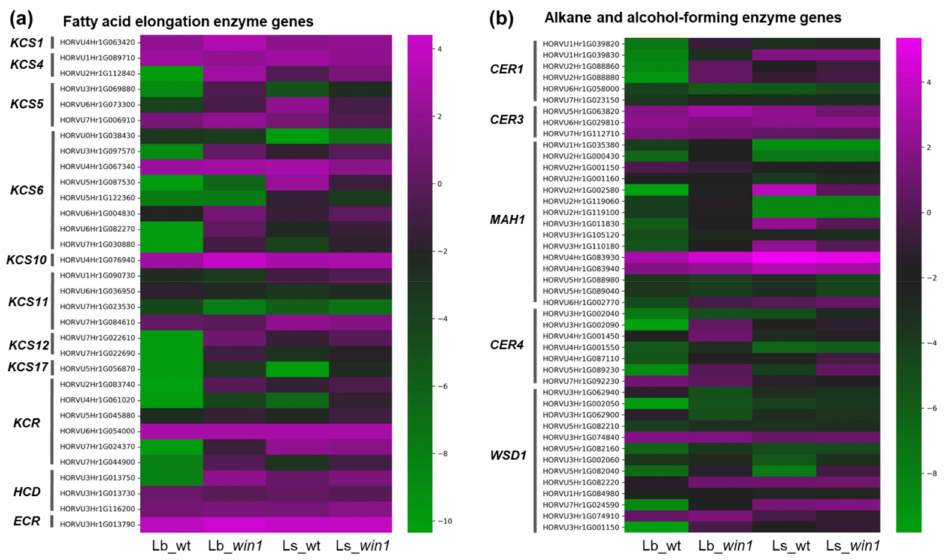
Figure 5. Expression heatmap of wax biosynthesis genes in wild-type and win1 KO leaf blades and leaf sheaths. ( a ) Expression of genes involved in fatty acid elongation. KCS—3-ketoac-CoA synthase, KCR—3-ketoacyl-CoA reductase, HCD—b-hydroxyacyl-CoA dehydratase, and ECR—enoyl-CoA reductase. ( b ) Expression of alkane and alcohol-forming enzyme genes. CER1, CER3—acyl-CoA de- carbonylases, MAH1—midchain alkane hydroxylase, CER4—fatty acyl-CoA reductase, and WSD1— wax ester synthase. The magenta color denotes highly expressed genes, and green indicates genes with lower expression. The magenta-green gradient represents the change in fragments per kilobase of transcript per million mapped reads (FPKM)-normalized log2-transformed counts from high to low. lb_ win1 — win1 KO leaf blade; lb_wt—wild-type leaf blade; ls_ win1 — win1 KO leaf sheath; and ls_wt—wild-type leaf